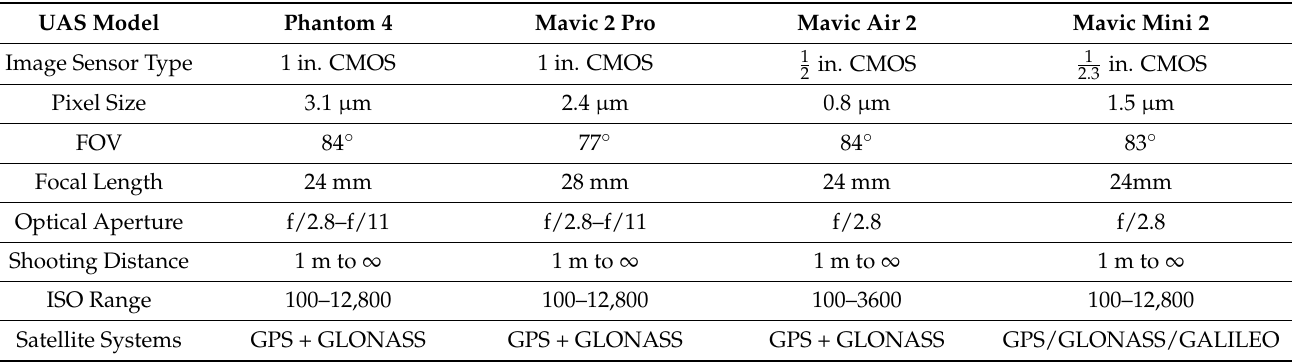
Table 1. UASs’ technical specifications.